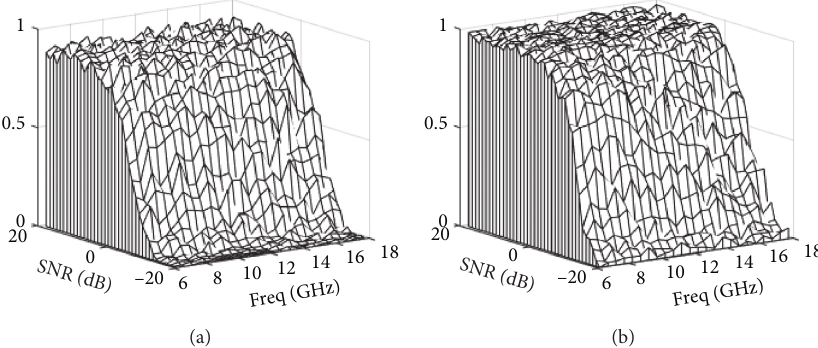
Figure 8: Array-3 probability of AoA estimation versus frequency and SNR: (a) RMSE ≤ 1 ° and (b) RMSE ≤ 5 ° , when M + 1 � 1025 for WF-3.